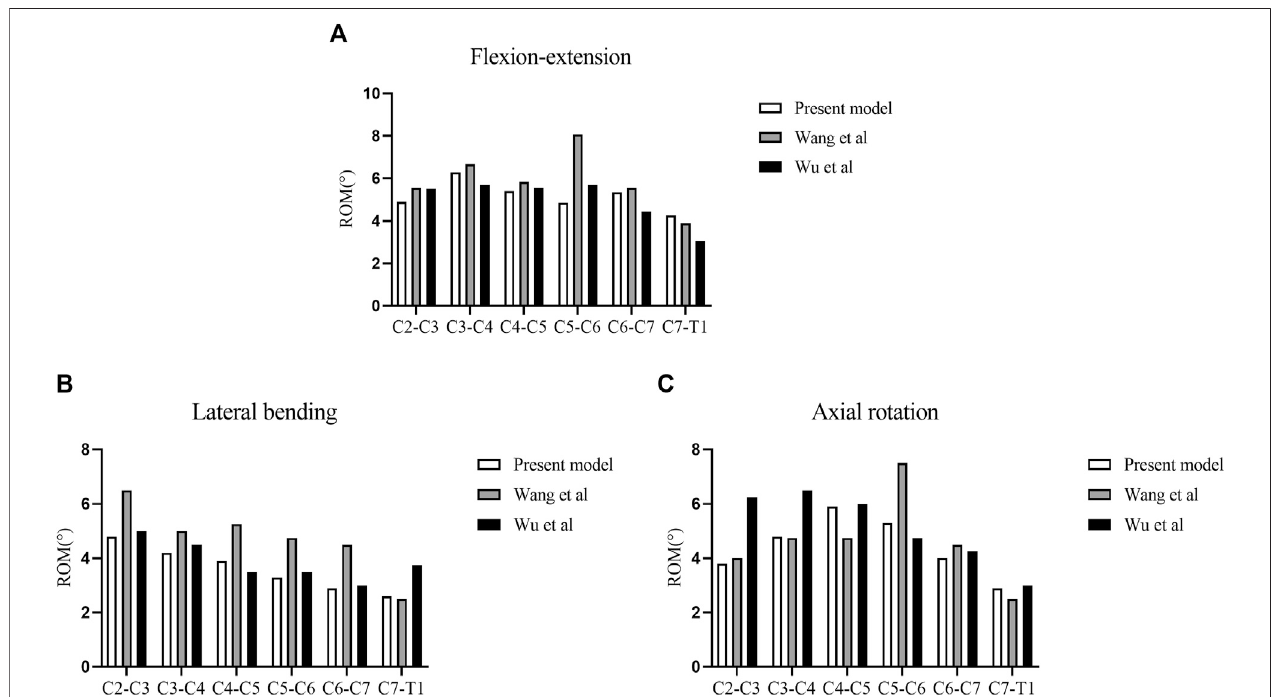
FIGURE 4 | Validation of the intact cervical model. (A) ROM in fl exion-extension. (B) ROM in lateral bending. (C) ROM in axial